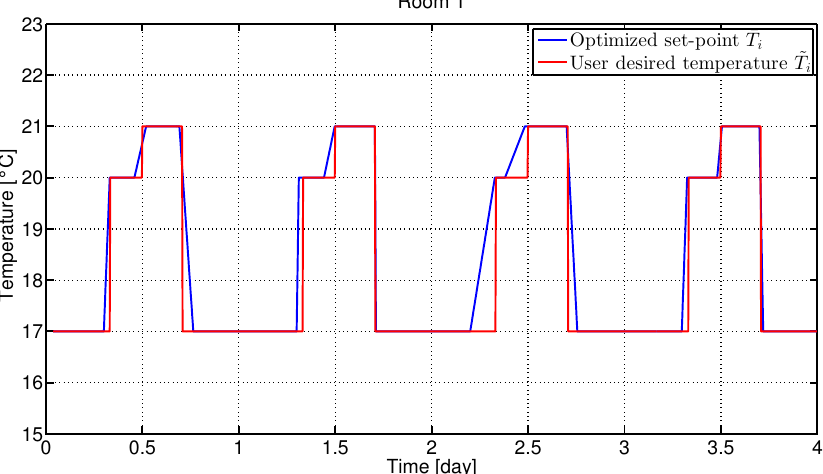
Figure 5. Four days simulation, from 15 November to 18 November, and optimal set-point signal planning, in case the optimized set point can change as a ramp signal. Red line: user defined set-point signal. Blue line: optimal set-point signal obtained by the genetic